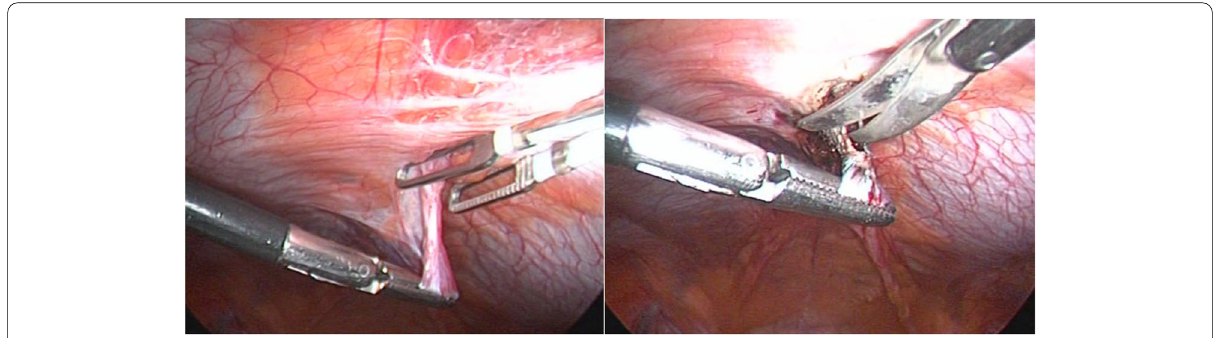
Fig. 6 Extraperitoneal intersection of a cranial part of an urachal